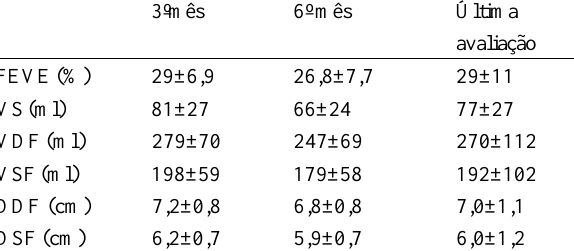
3. Variáveis ecocardiográficas no pós-operatório tardio.